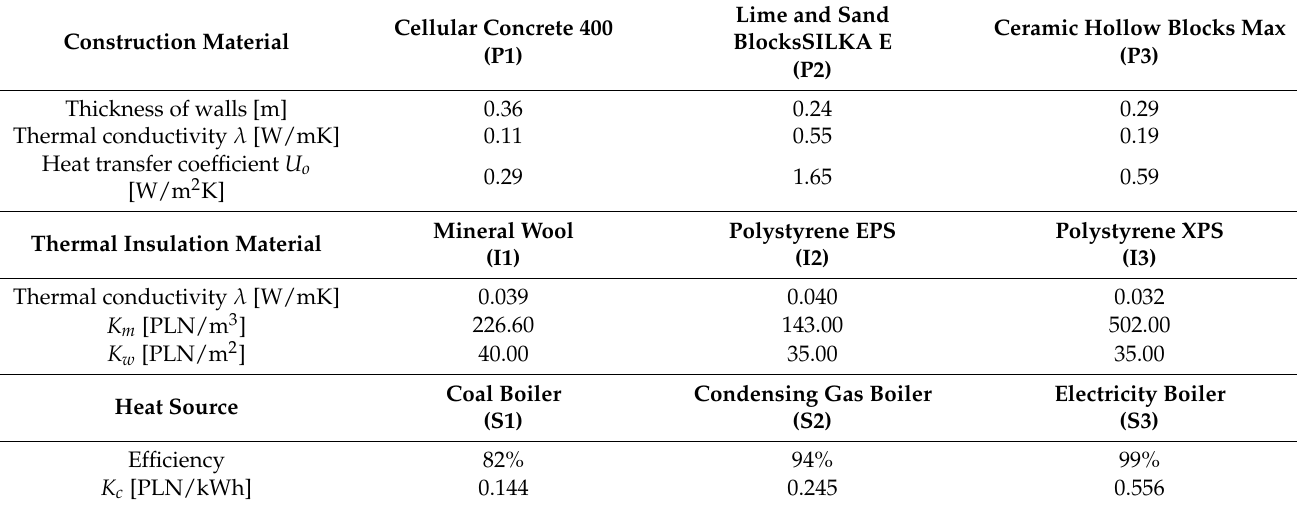
Table 2. Data for construction materials, thermal insulation materials and heat sources.